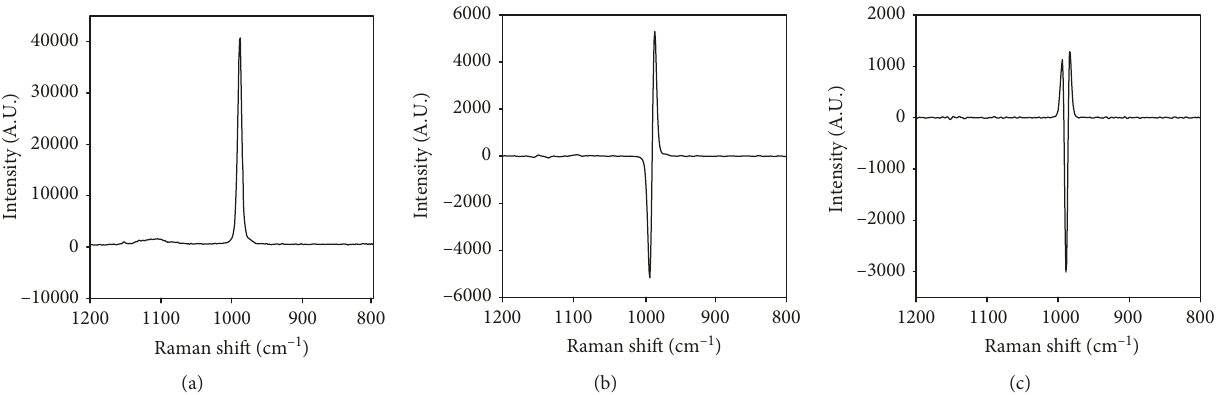
Figure 1: Raman spectra of natrii sulfas from 800 to 1200cm − 1 : (a) original spectra; (b) spectra pretreated by FD; (c) spectra pretreated by